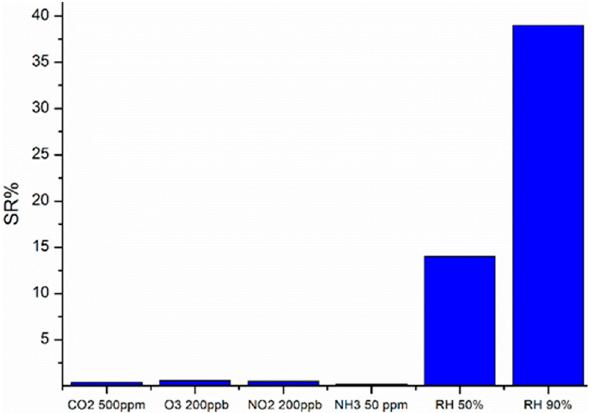
Figure 12. Cross sensitivity test of CGB sensor towards CO 2 500 ppm, O 3 200ppb, NO 2 ppb and NH 3 50 ppm.